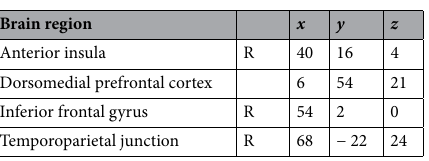
Table 4. List of seed regions and their MNI coordinates. x , y , z : coordinate in